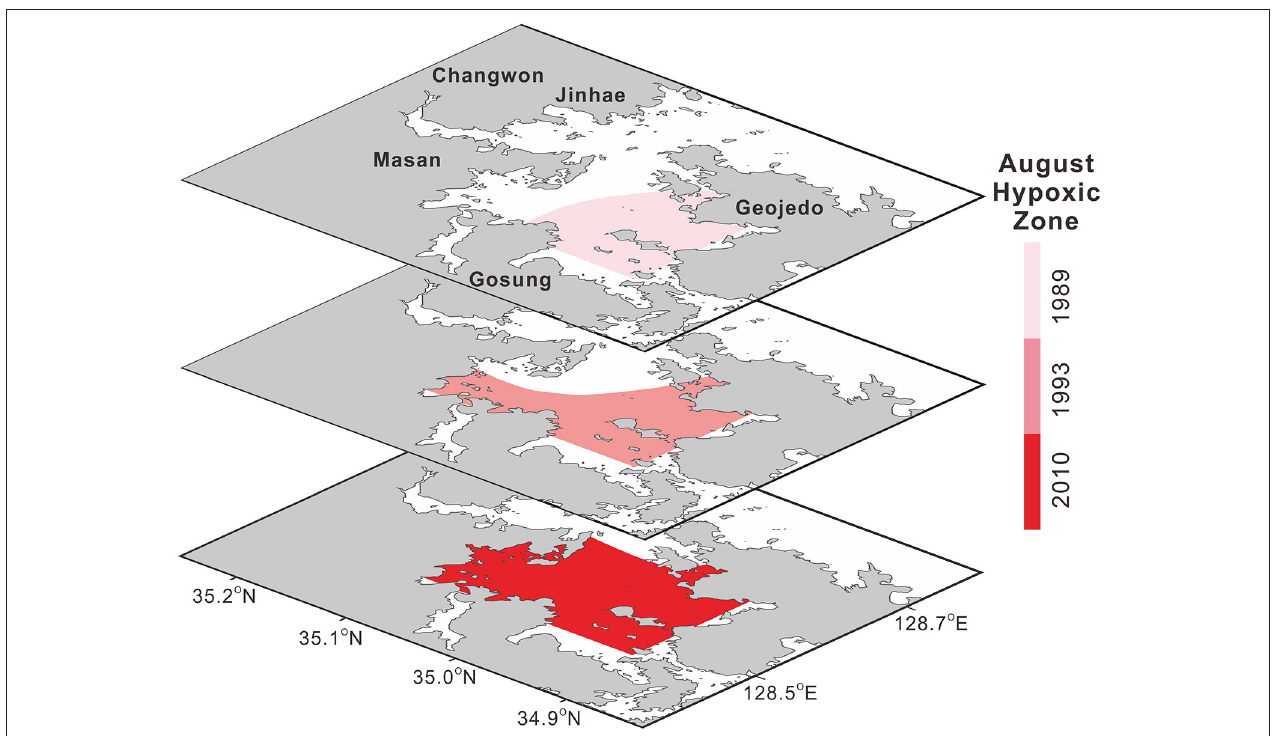
FIGURE 4 | Decadal variation in the areal extent of summer (August) hypoxia in Jinhae Bay (shown for 1989, 1993, and 2010). Sources: Modified from Kim and Lee (1994) . Reproduced with permission of the Korean Society of Fisheries and Aquatic Science, Modified from Lim et al. (2006), and Modified from Kim S.-Y. et al. (2012). Reproduced with permission of the Korean Society of Nature